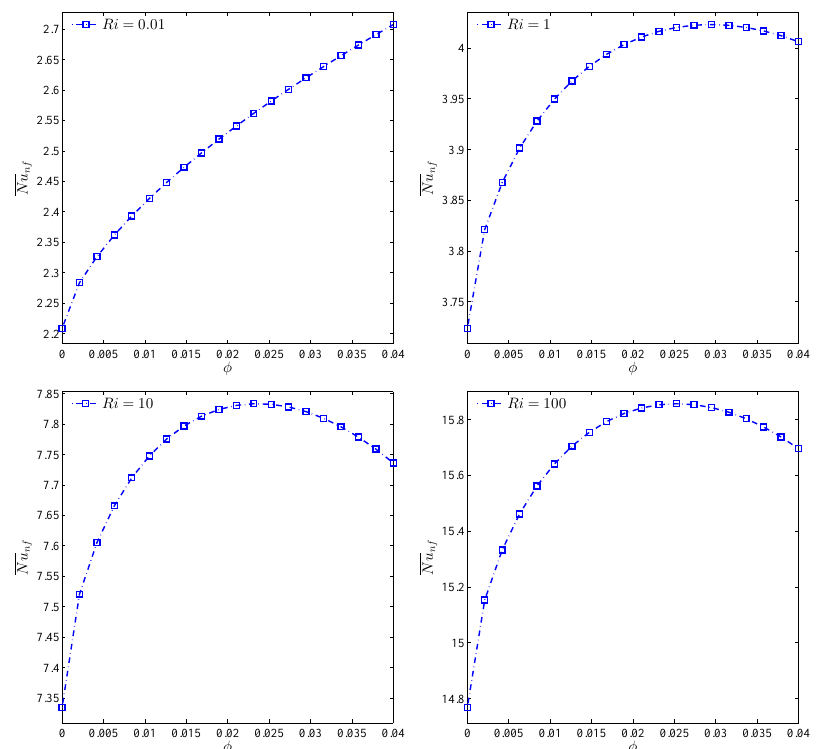
Figure 12. Variations of the average Nusselt number with φ for different Ri at Case 1 ( Ω ), N = 3 and R =